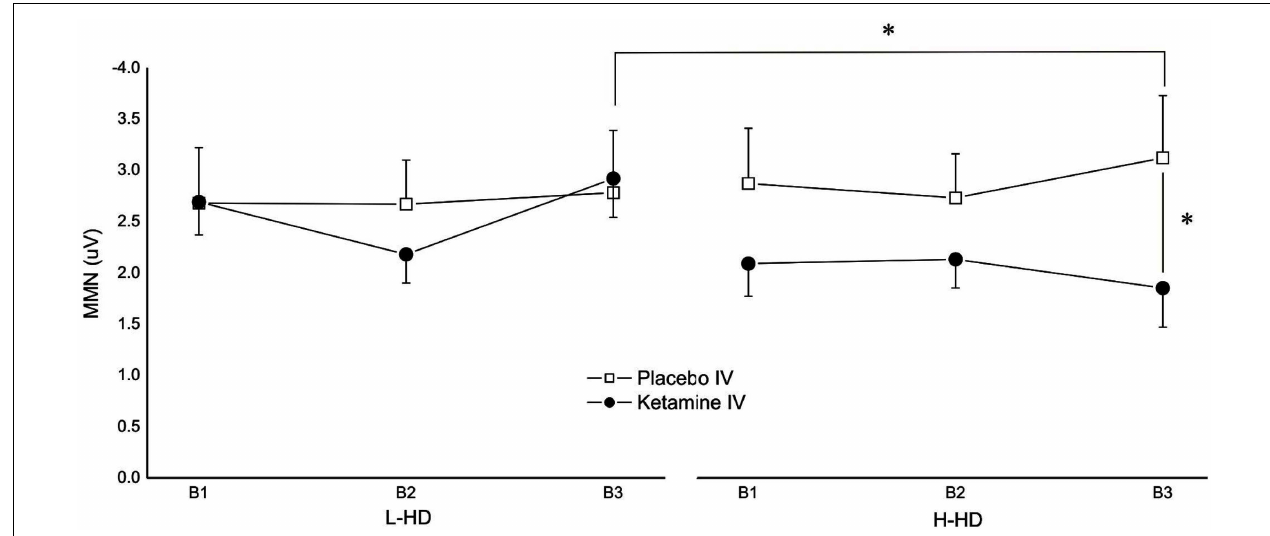
FIGURE 1 | Effects of placebo and ketamine infusion (collapsed across placebo and nicotine gum) on frontal (F z ) mean ( ± SE) MMN amplitudes of L-HD and H-HD participants in the three time blocks (B1–B3; * p <